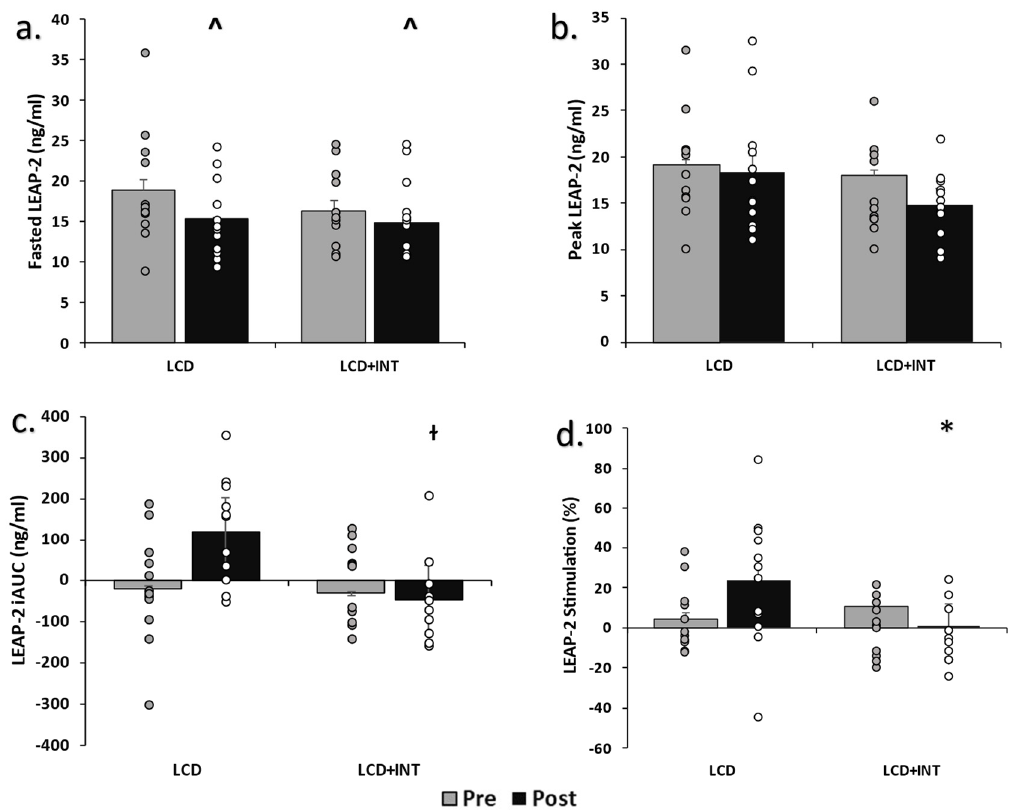
Figure 1. Circulating LEAP-2 before and after treatments. Note: Raw data shown as mean ± SEM, log transformed for analysis. ( a ). Fasted LEAP-2 pre- and post-intervention measurements, ( b ). LEAP-2 peak pre- and post-intervention, ( c ). LEAP-2 incremental area under the curve pre- and post-intervention, ( d ). LEAP-2 precent stimulation pre- and post-intervention, LCD: Low-calorie diet; LCD+INT: Low-calorie diet plus interval training; iAUC: incremental area under the curve; LEAP-2: Liver-expressed antimicrobial enzyme-2, Peak: highest observed value, ^ Time effect p = 0.05, ɫ Group × time effect, p = 0.06, * Group × time effect, p = 0.04. Visual Analog Scale: LCD or LCD+INT tended to reduce fasted desire for sweets (17.0 Correlations: Higher circulating LEAP-2 30 min related to lower circulating AG 30 min pre- (r = − 0.41, p = 0.04) and post-intervention (r = − 0.51, p = 0.01). There was no relationship between pre-intervention fasted LEAP-2 and fasted sweet VAS (r = − 0.07, p = 0.71) or fasted salty VAS (r = 0.03, p = 0.88). Likewise, LEAP-2 60 min was not associated with 120 min sweet VAS (r = 0.26, p = 0.26) or 120 min salty VAS (r = 0.12, p = 0.55), respectively. Table 3. Perceived Appetite. However, post-intervention higher LEAP-2 60 min tended to associate with higher 120 min measures of sweet (r = 0.40, p = 0.07) and salty (r = 0.41, p = 0.06; Figure 2). There was no LCD LCD+INT pre-intervention relationship between LEAP iAUC 60 min and FFA iAUC 180 min (r = − 0.11, p = 0.57). Yet, higher post-LEAP-2 iAUC 60 min was linked to higher post-FFA iAUC 180 min (r = 0.56, p = 0.007; Figure